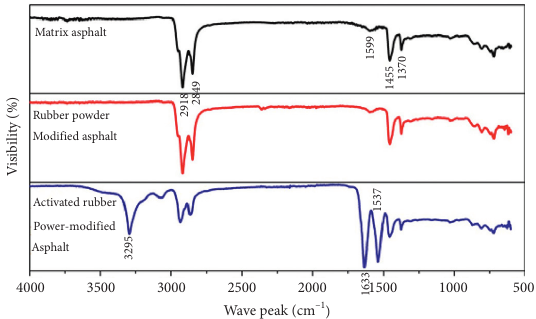
Figure 7: Infrared spectrum test